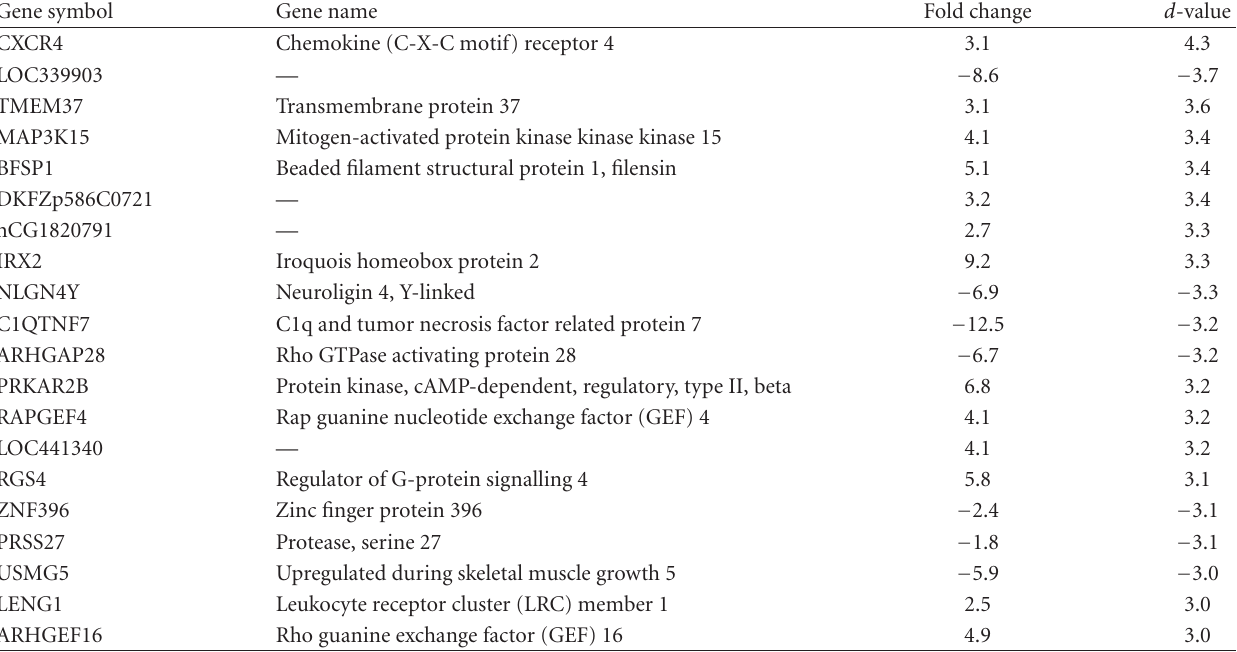
Table 4: Top-20 genes identified by SAM analysis as di ff erentially expressed in the comparison of primary samples from patients who developed metastases and those who did